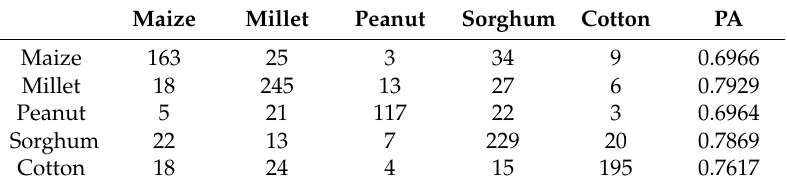
Table 8. Confusion matrix applying an ensemble of 100 classifiers. PA: Producer accuracy per